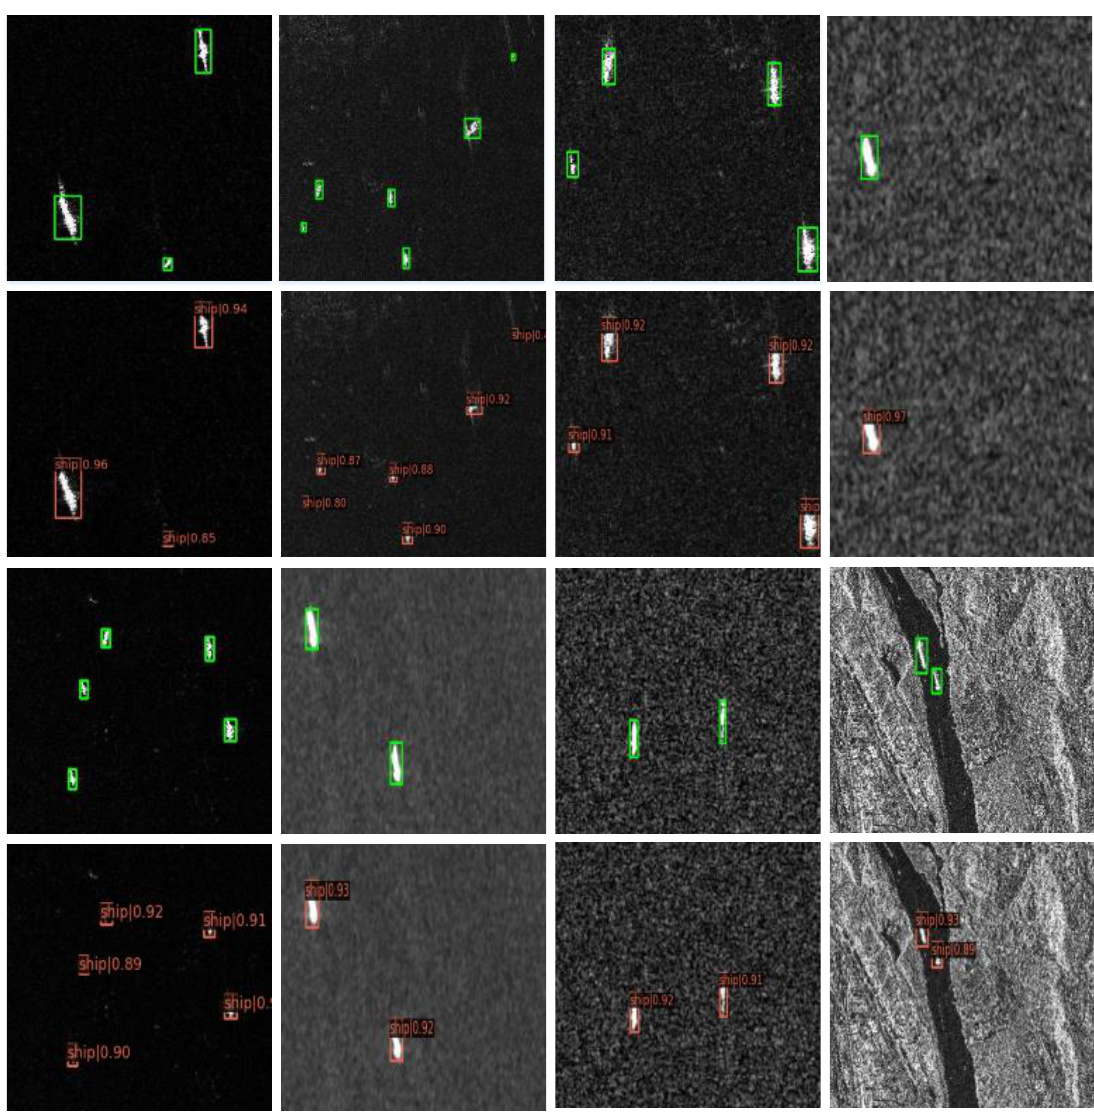
Figure 14. Visual results of R-FCOS on SSDD. The green rectangles and red rectangles are the ground truth and detection results, respectively.